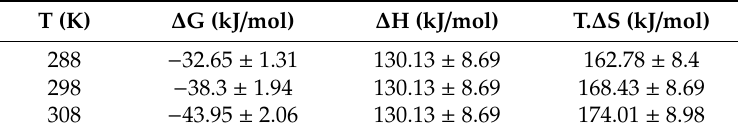
Table 2. Thermodynamic parameters of the complex NBD-piperine at temperatures of 288 K, 298 K and 308